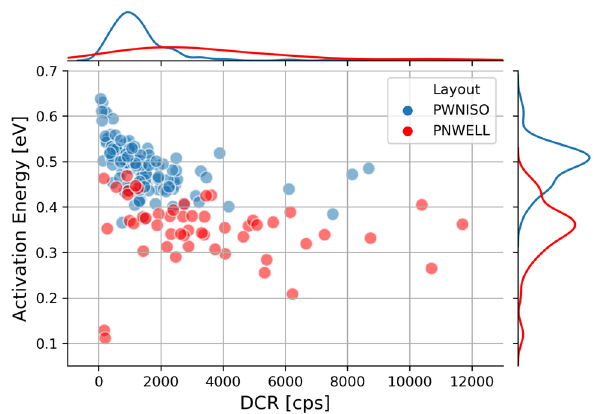
Figure 4. Activation energies versus DCR at room temperature for P+/Nwell (red points) and Pwell/Niso (blue points)